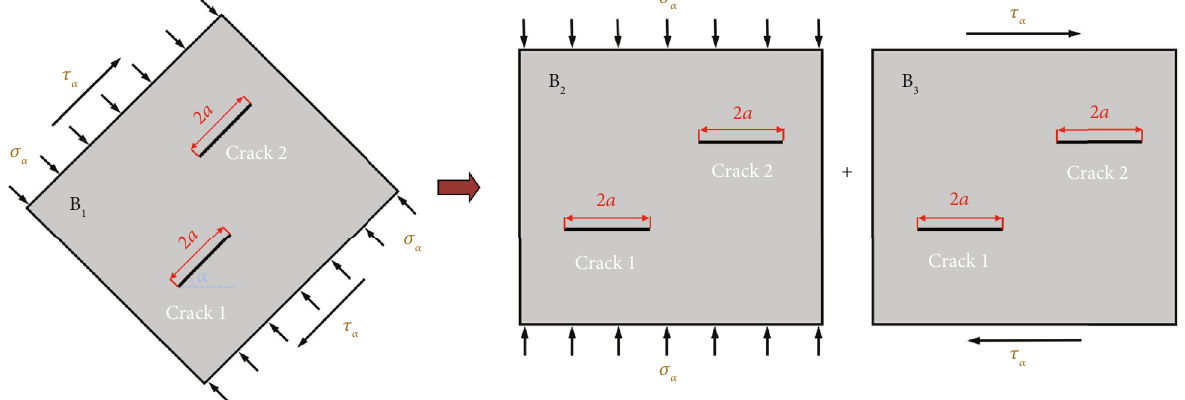
Figure 4: Superposition sketch of stress State B